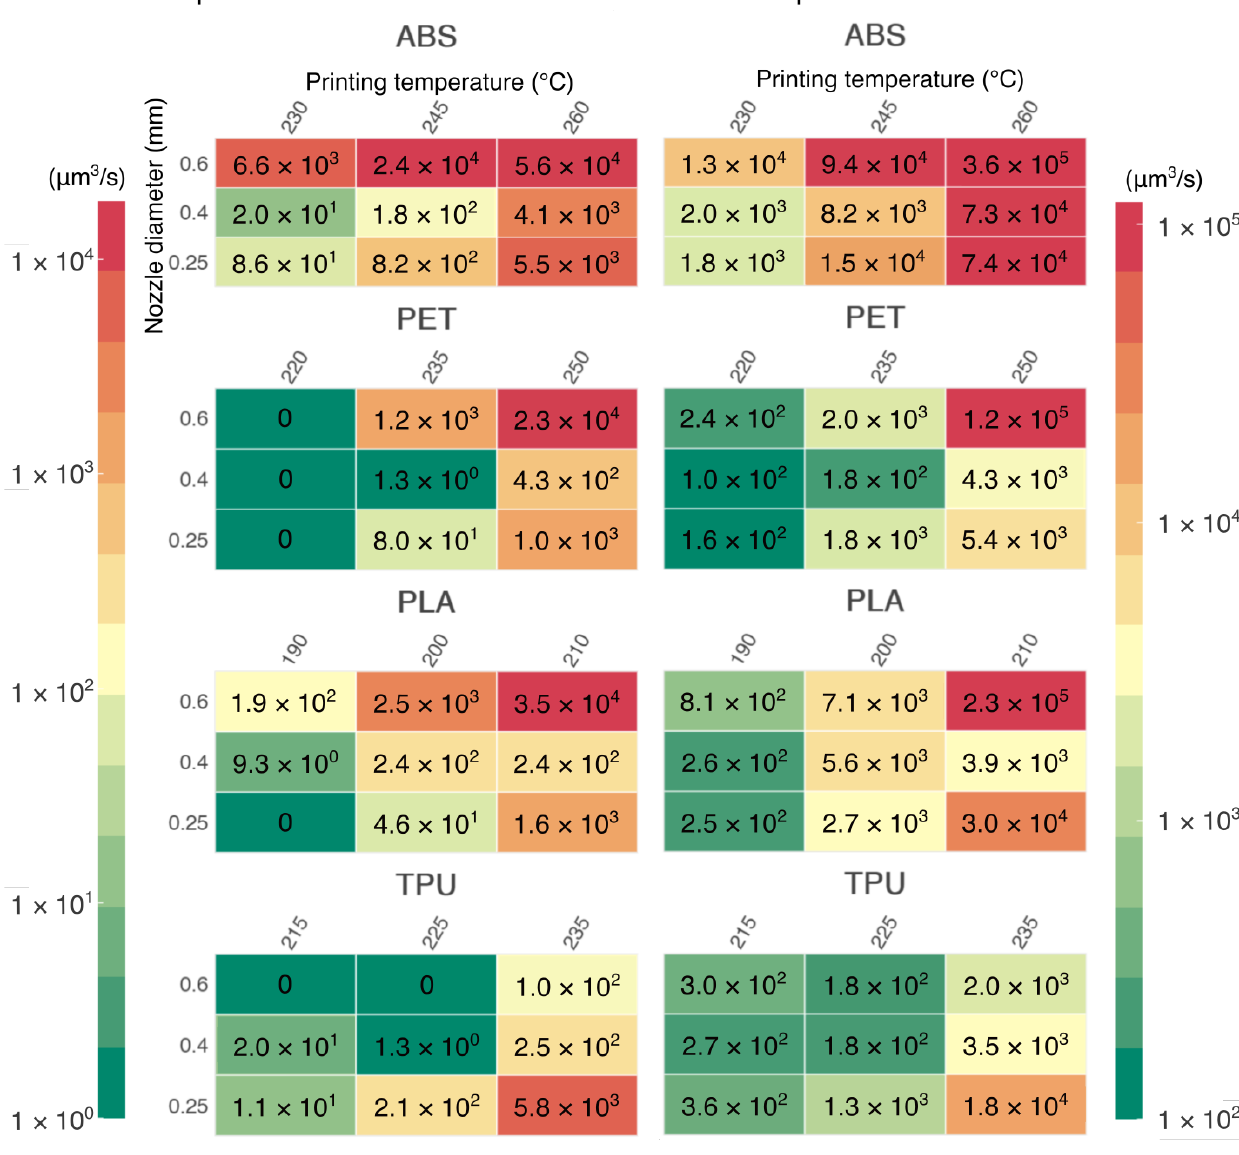
Figure 7. Mean particle volume formation rate during the printing period and peak particle volume formation rate for measured configurations.